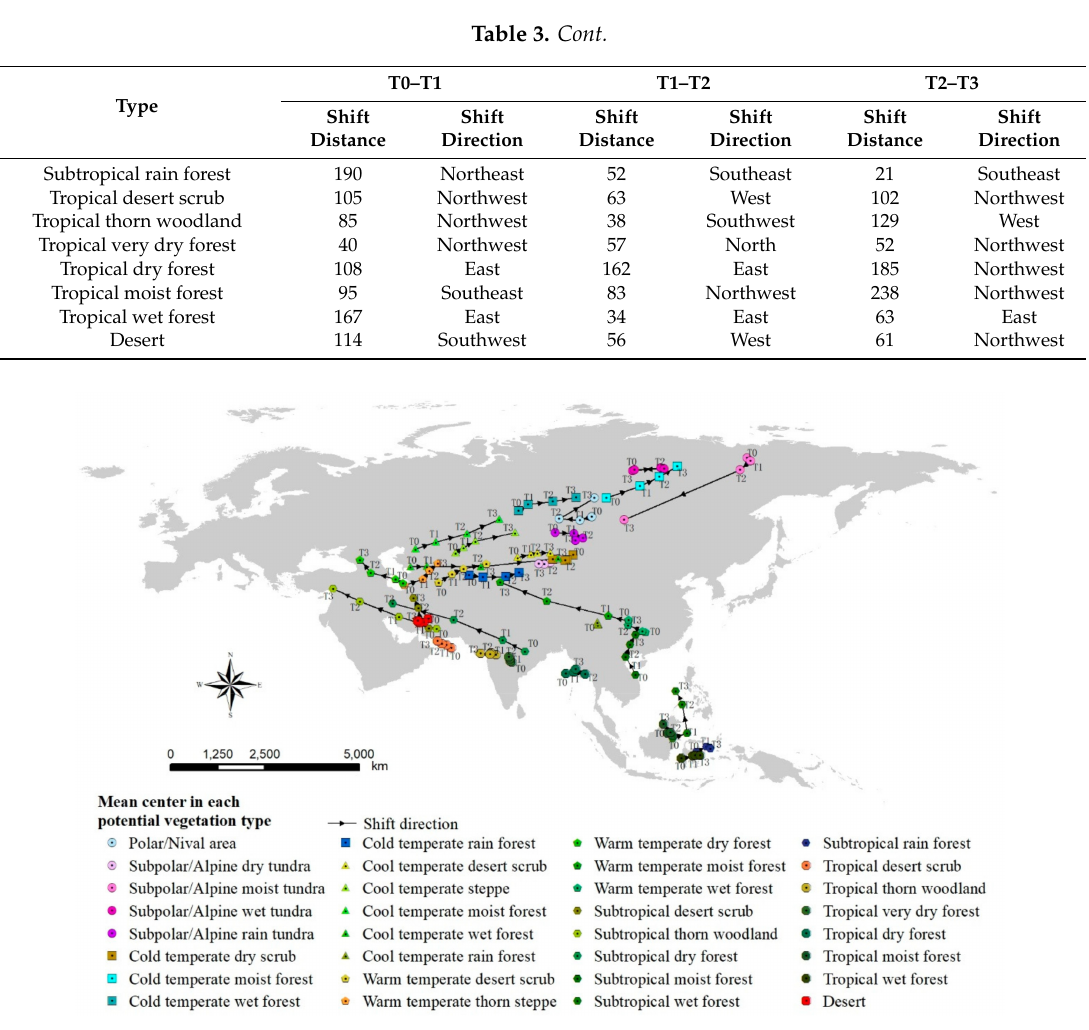
Figure 4. Shift trends of the mean centers of each potential vegetation type under the RCP4.5 scenario in